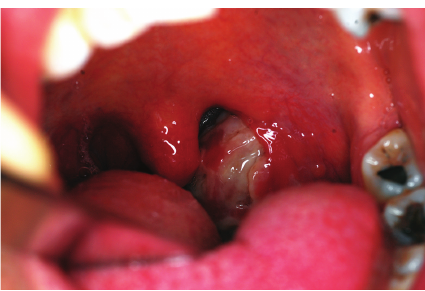
Figure 1: Chlamydia trachomatis tonsillopharyngitis. There is gen- eralized pharyngeal and tonsillar hyperemia with di ff use purulent exudate on the left tonsil and swollen anterior pillars and